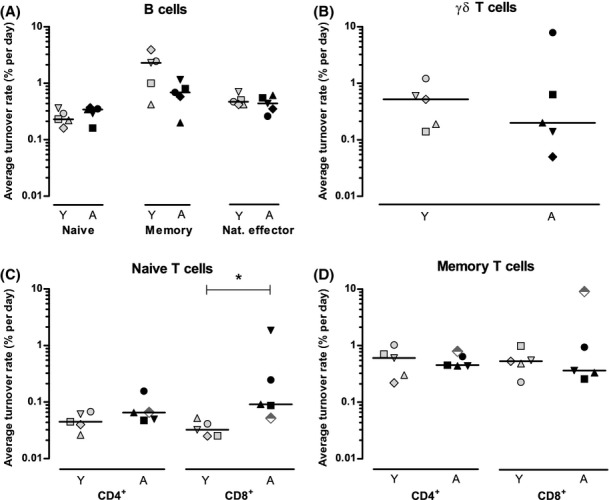
Summary of estimated average turnover rates in young and elderly individuals. Estimates of the average turnover rate of (A) naive, memory, and natural effector B cells, (B) γδ T cells, (C) naive CD4+ and CD8+ T cells, and (D) memory CD4+ and CD8+ T cells in young (gray symbols) and aged (black symbols) individuals. The elderly male tested seropositive for CMV is depicted by a semi-filled diamond (C+D). All estimates were obtained by fitting the multi-exponential model to the individual data sets (see Supporting Information). Horizontal lines represent median values. The asterisk marks a significant difference (P-value < 0.05) between young and aged individuals. Individual fits are shown in Figs S3–S5. Different symbols indicate different individuals within panels (A+B) and panels (C+D).